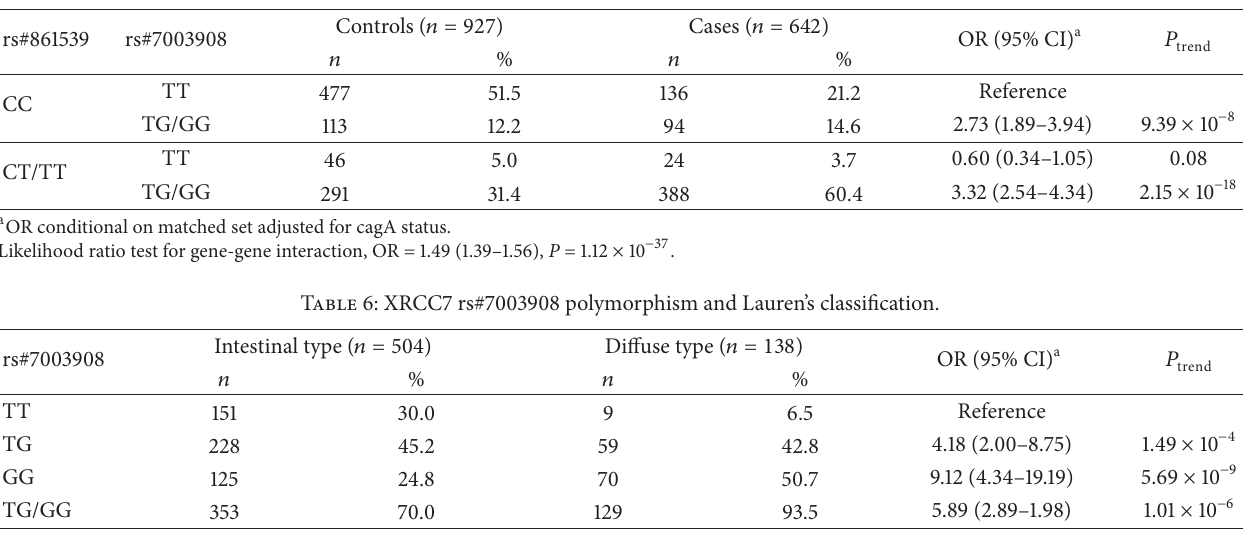
Table 5: Joint effects of XRCC7 rs#7003908 polymorphism and XRCC3 rs#861539 on GAA risk.